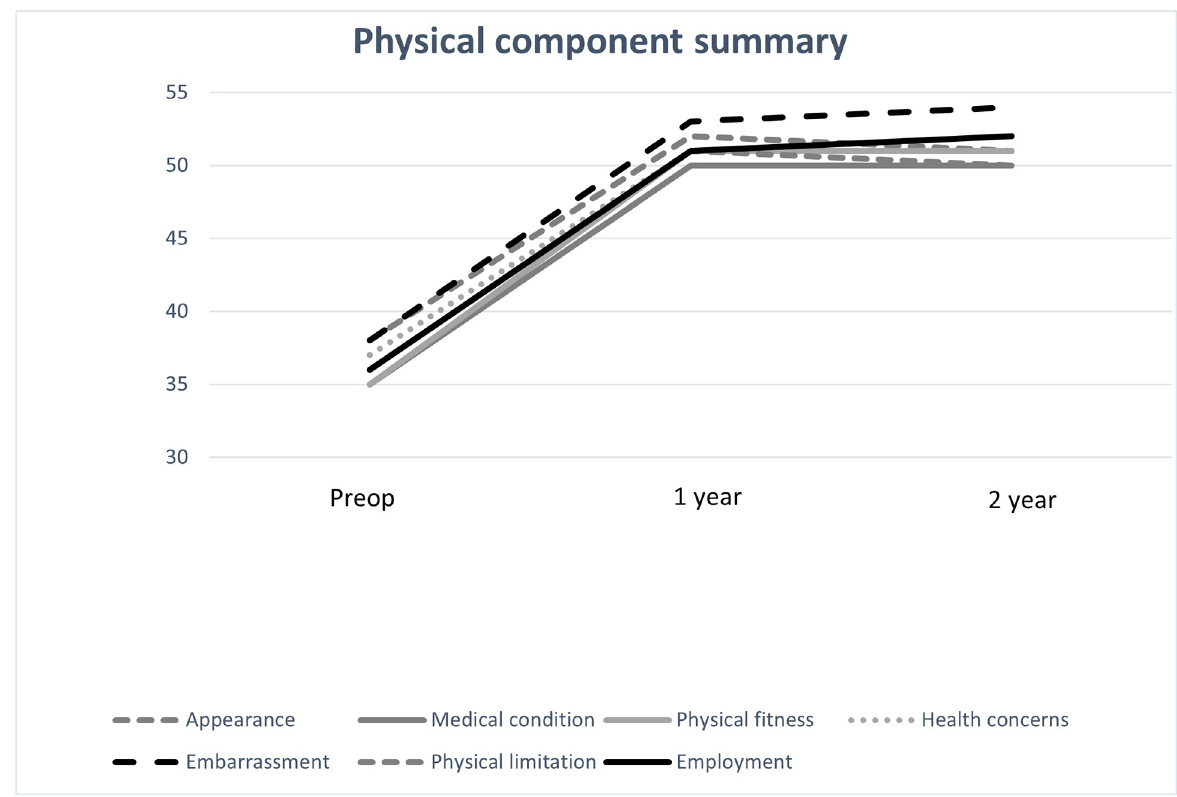
Fig 1. Physical component summary (PCS) scores and reasons for undergoing surgery, analyzed using dependent t- test. All categories increased significantly 1-year after surgery (p = 0.001) and 2-years (p = 0.001). Missing: preoperatively n = 112, 1-year n = 178, 2-year n =